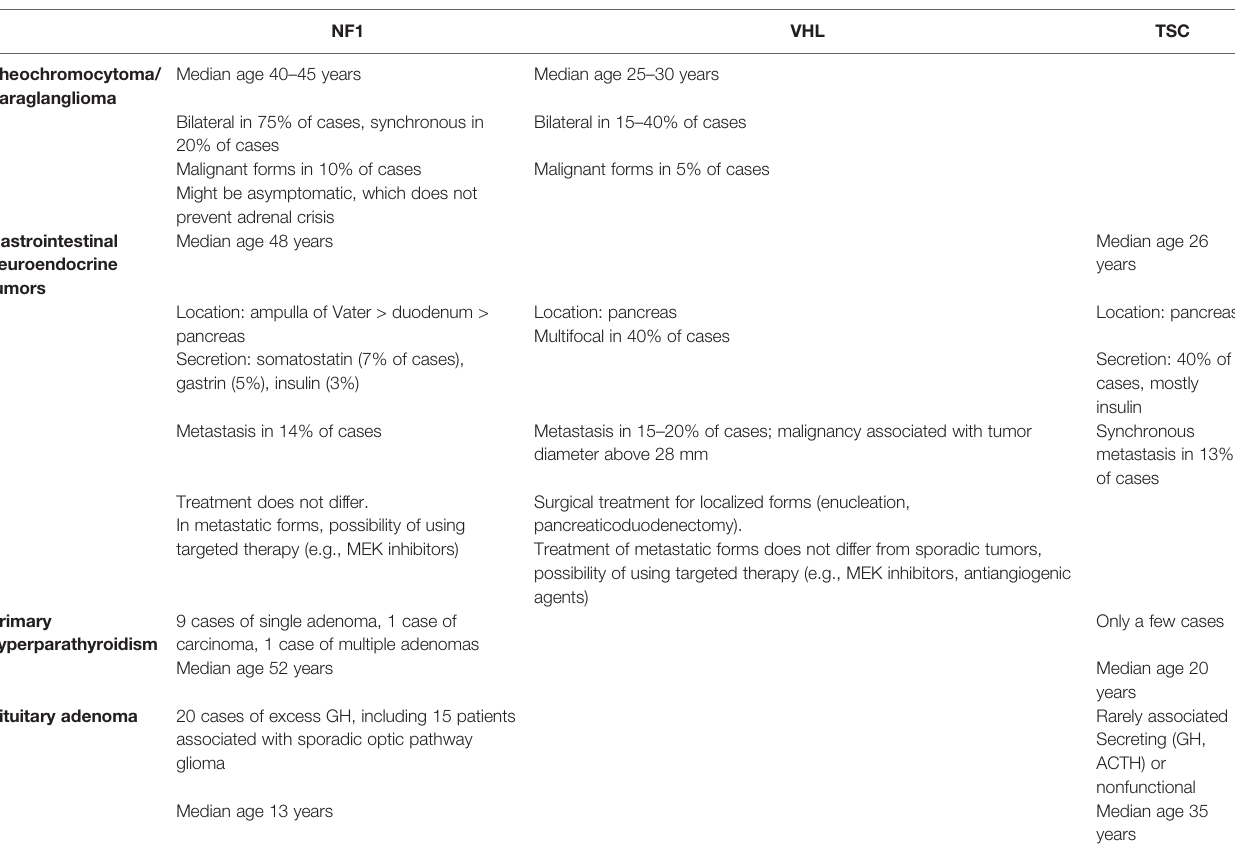
TABLE 6 | Endocrine tumors and phakomatoses speci fi